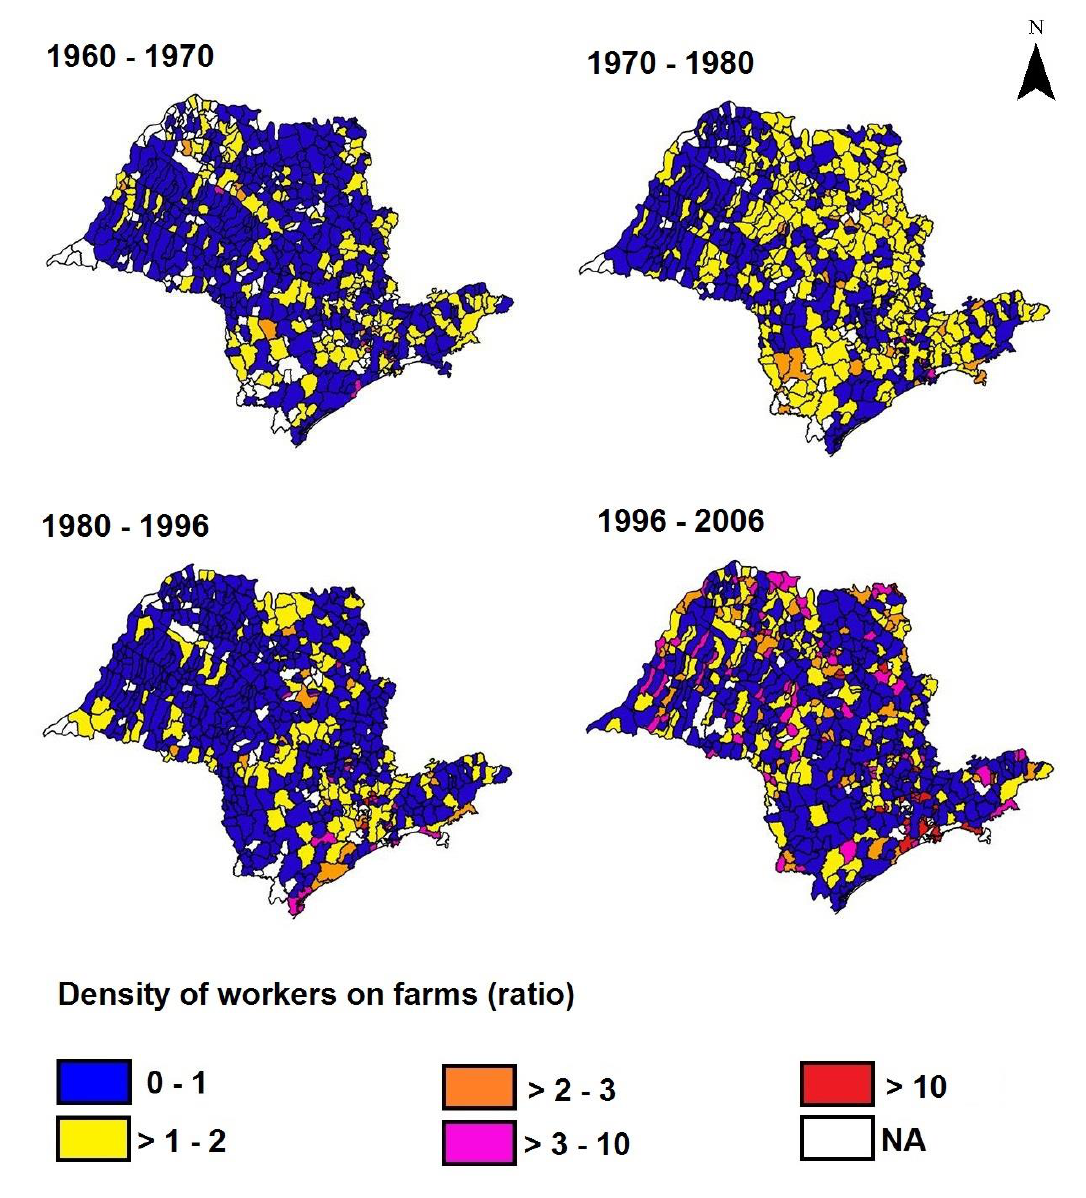
FIGURE A1.4 Density of workers on farms ratio at the municipality-scale for São Paulo state calculated for the intervals 1960-1970, 1970-1980, 1980-1996 and 1996-2006. Density of workers on farms ratio was calculated by dividing the density of workers in one census by the density of workers in the previous census (e.g. values in 1970 / values in 1960). Ratio values greater than 1 (one) indicate that density of workers increased over the census interval and values lower than 1 (one) indicate that it decreased. Municipality boundaries are shown in black. (NA) Missing